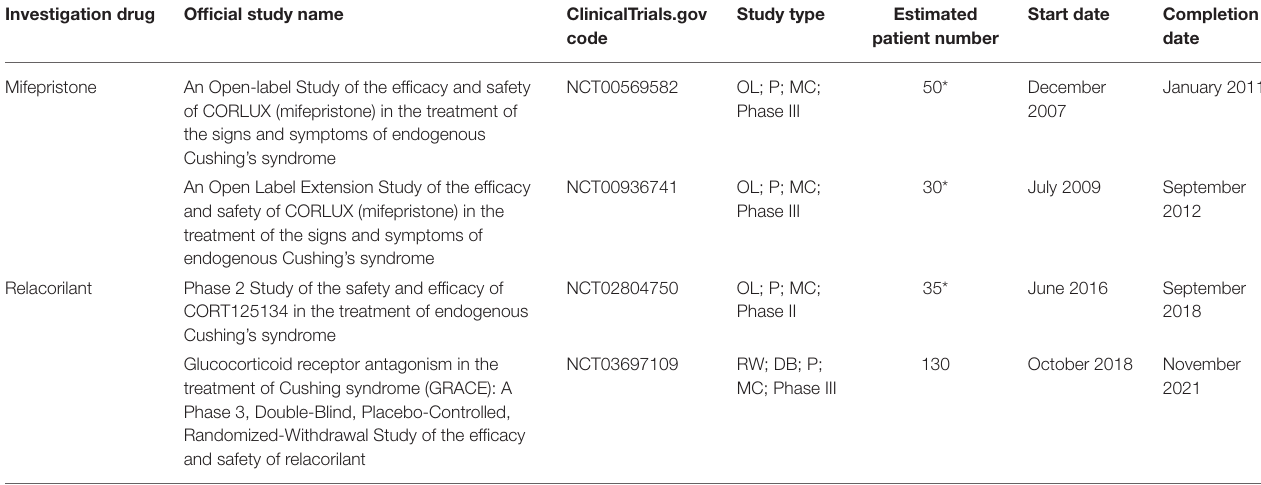
TABLE 4 | Characteristics of current and recent clinical trials, registered in clinicaltrials.gov, on glucocorticoid-receptor antagonists for the treatment of Cushing’s disease and Cushing’s syndrome in terms of official study name, identification code, study design, patient number, start, and completion